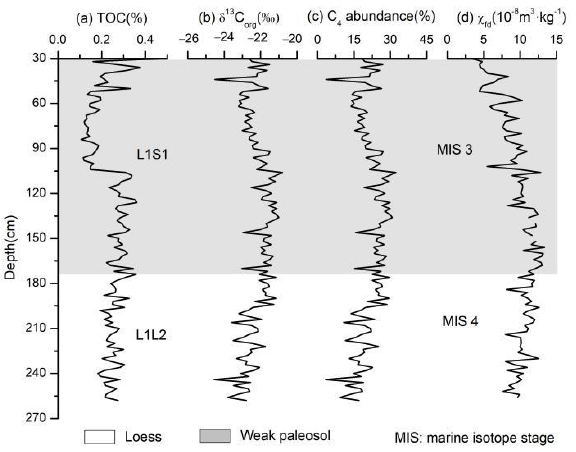
Figure 3. Variations in ( a ) TOC, ( b ) δ 13 C org composition, ( c ) C 4 abundance and ( d ) χ fd of the CQS section.